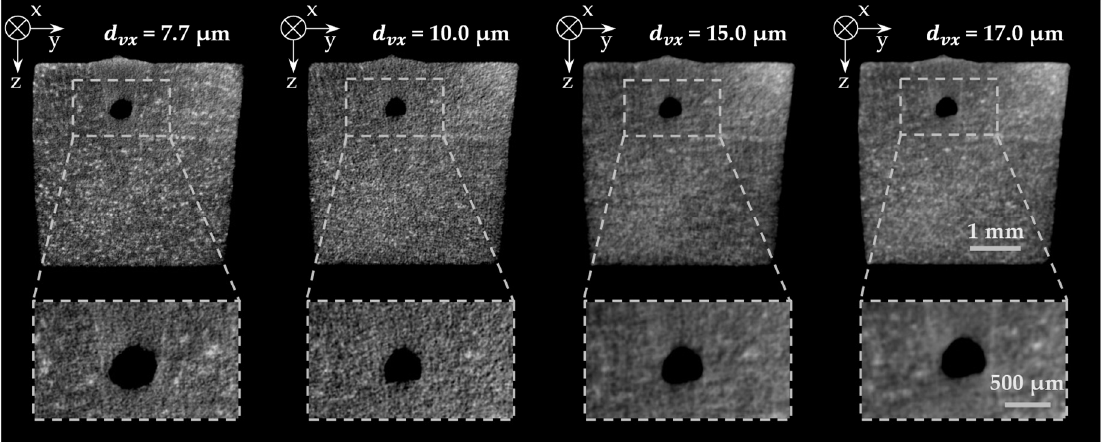
Figure 5. Evaluation of the influence of the measurement resolution on the differentiability of the microstructure of the base material and the weld seam for voxel sizes d vx between 7.7 μ m and 17 μ m using cross ‐ sectional evaluations of the 3D μ CT scans; material AA 2219, laser power 1.5 kW, feed rate 9 m/min.